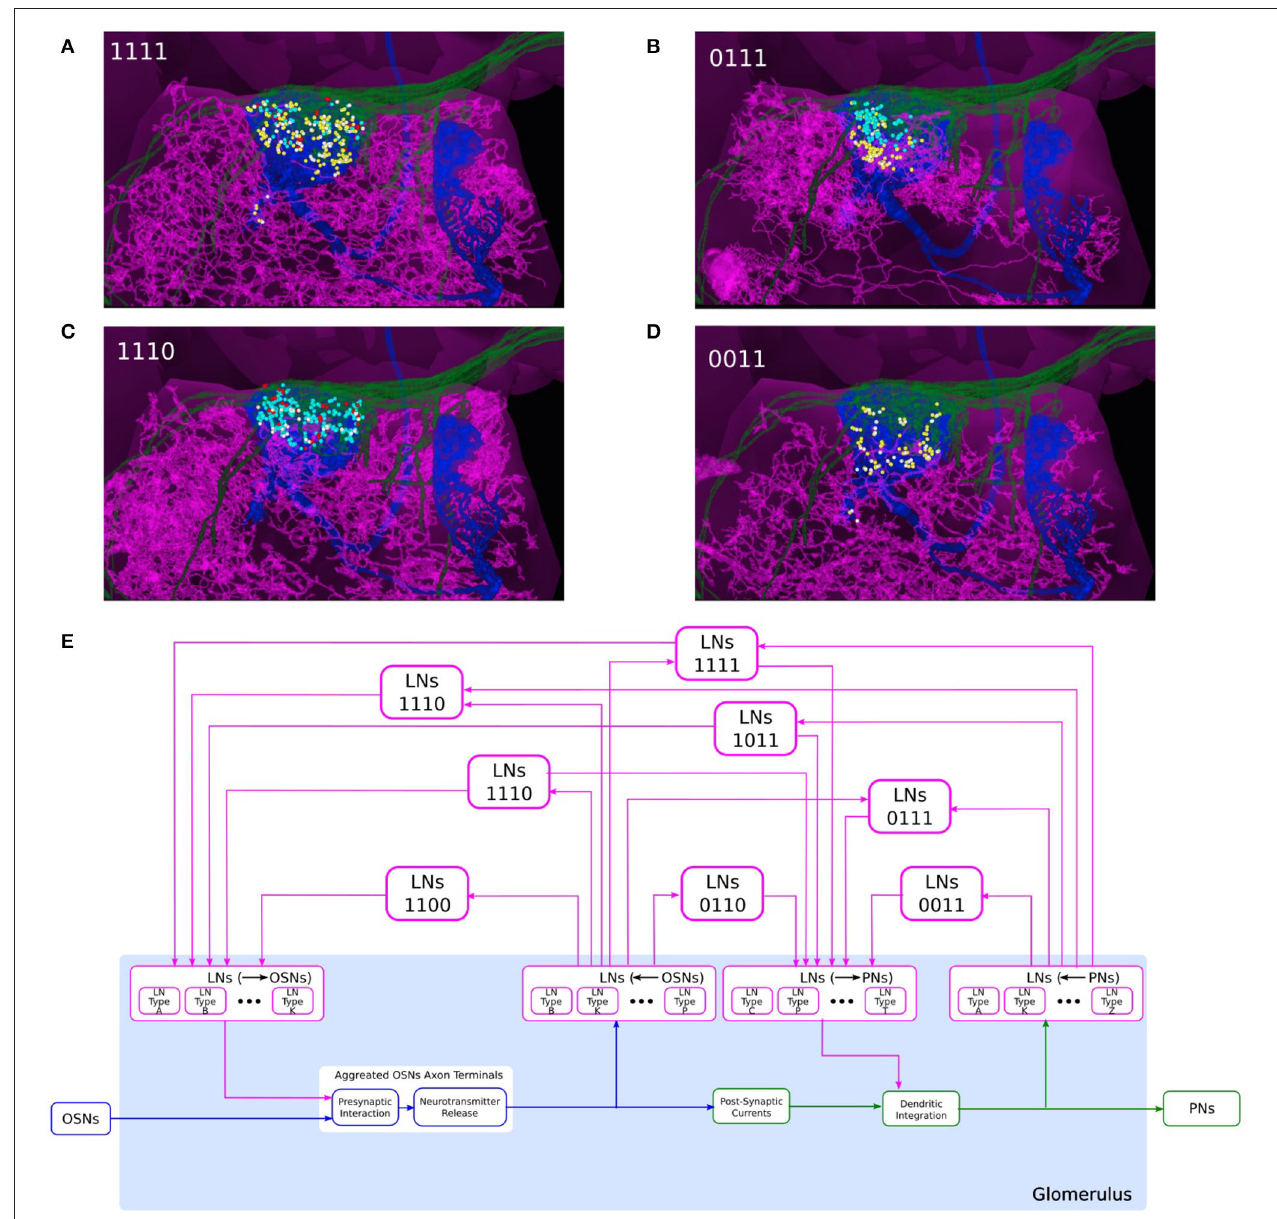
FIGURE 7 | Composability of the port connectivity of LNs within a glomerulus. (A–D) Examples of LNs with different port connectivity patterns in the DL5 glomerulus. (A) 1111, (B) 0111, (C) 1110, and (D) 0011 (see also (E)). (magenta) LN, (green) the OSNs that project to DL5 glomerulus, (blue) the PN that innervates the DL5 glomerulus, (cyan dots) locations of OSN-to-LN synapses, (red dots) locations of LN-to-OSN synapses, (yellow dots) locations of PN-to-LN synapses, (white dots) locations of LN-to-PN synapses. (E) Schematic diagram of a single glomerulus circuit. (bottom) The blocks at the very bottom of the glomerulus represent the feedforward circuits. (top) LNs with different port connectivity patterns. Port connectivity patterns that have less than 50 occurrences in the Hemibrain dataset are omitted (see also Supplementary Table S1 in Supplementary Material